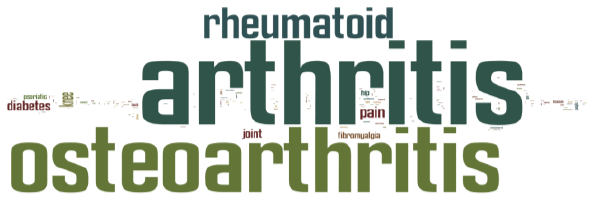
Figure 4. Medical condition people wanted to focus on. The word cloud provides a graphical representation of frequency of